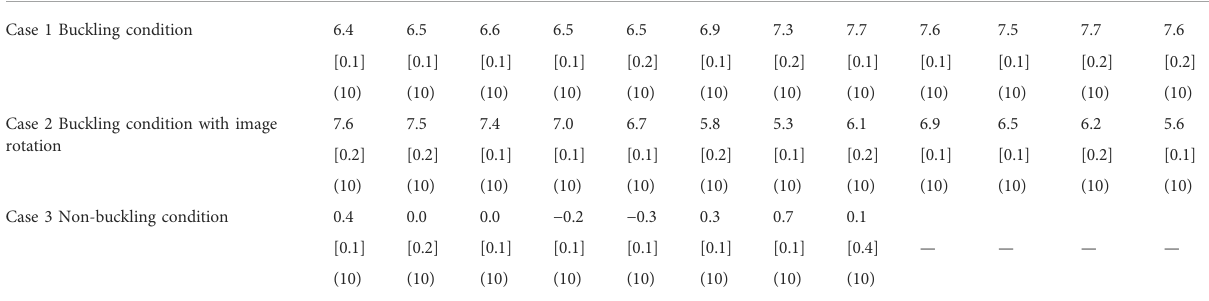
TABLE 1 Measured angles of in-service steel sheet piles by using a digital angle meter.